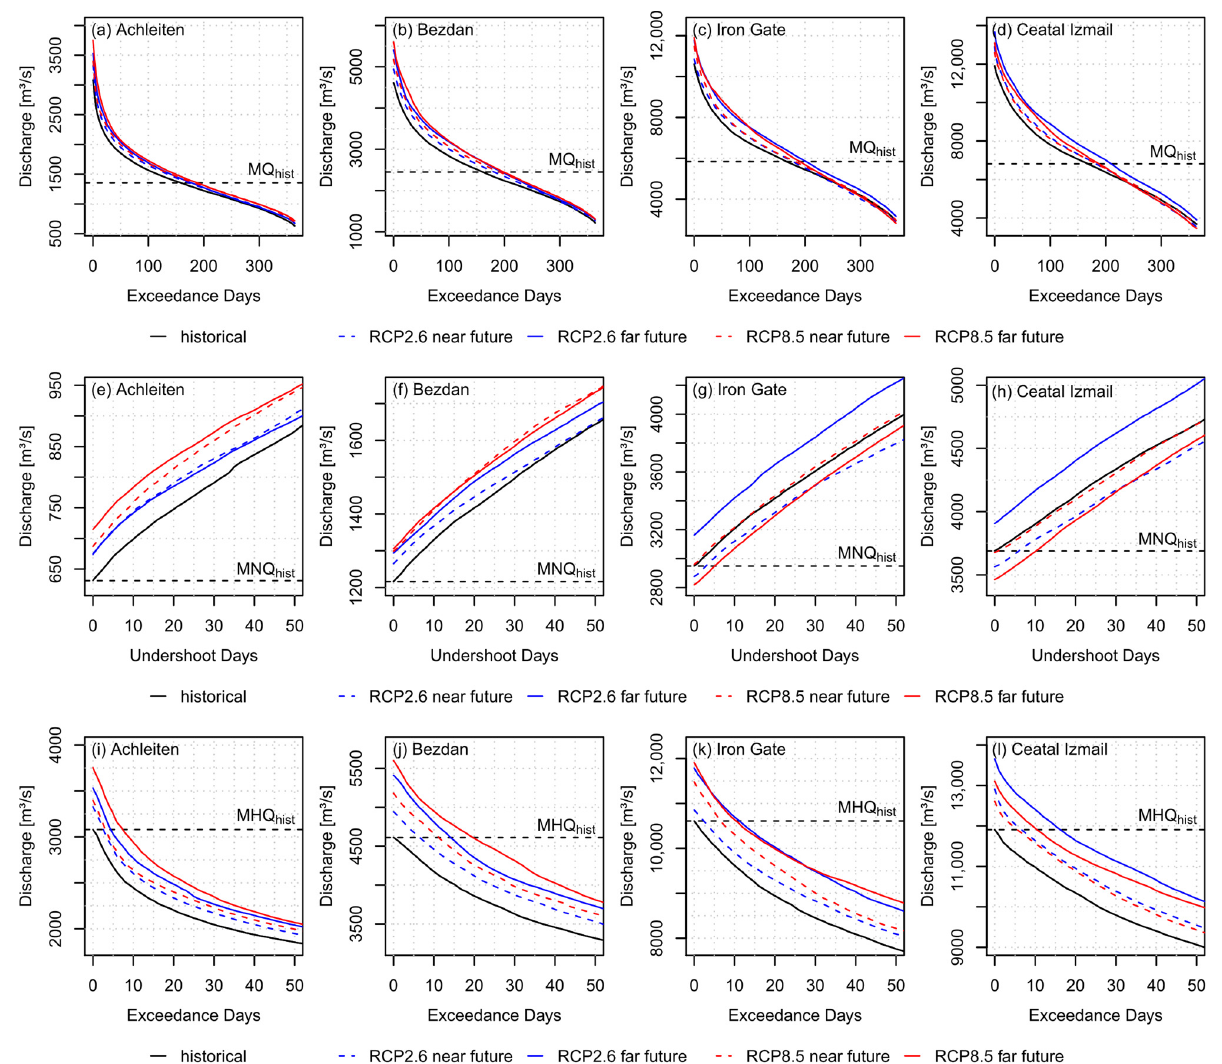
Figure 14. Flow duration curves for different gauges along the main course of the Danube (gauges Achleiten, Bezdan, Iron Gate and Ceatal Izmail) for the historical GCM-RCM-driven simulations (ensemble mean, 1971–2000) as well as for the GCM-RCM-driven simulations (ensemble mean) under RCP2.6 and RCP8.5 for the near future (2031–2060) and the far future (2071–2100). The graphs in subplots ( a – d ) show the average number of days in a year in which the daily discharge values are exceeded. The graphs in subplots ( e – h ) are zoomed-in near the historical long-term mean annual low flow (MNQ) values and the graphs in subplots ( i – l ) are zoomed-in near the historical long-term mean annual high flow (MHQ) values at the respective gauges.